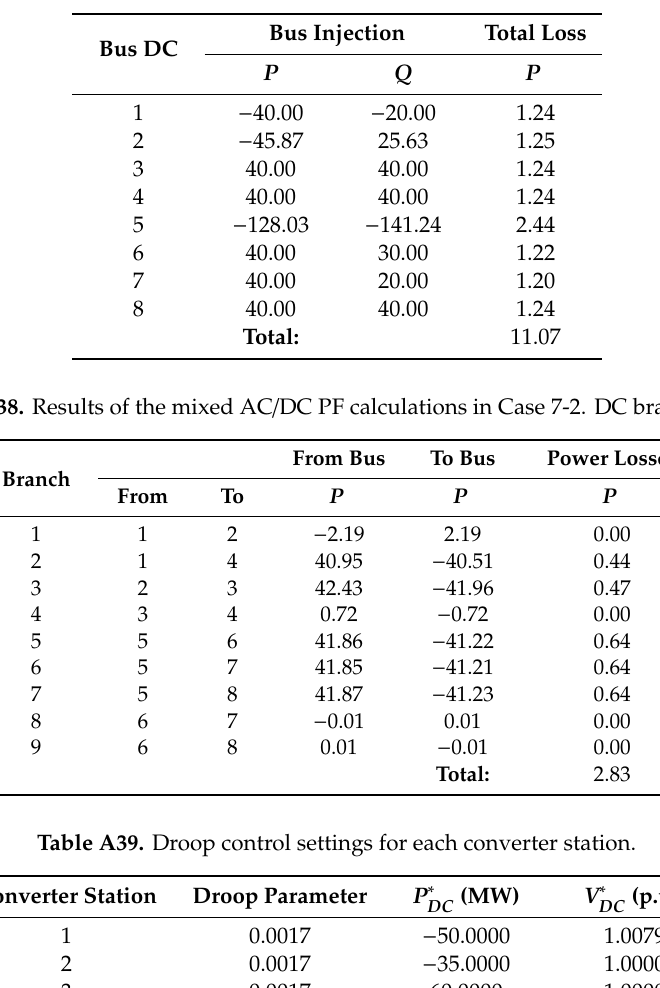
Table A37. Results of the mixed AC / DC PF calculations in Case 7-2. DC bus data.